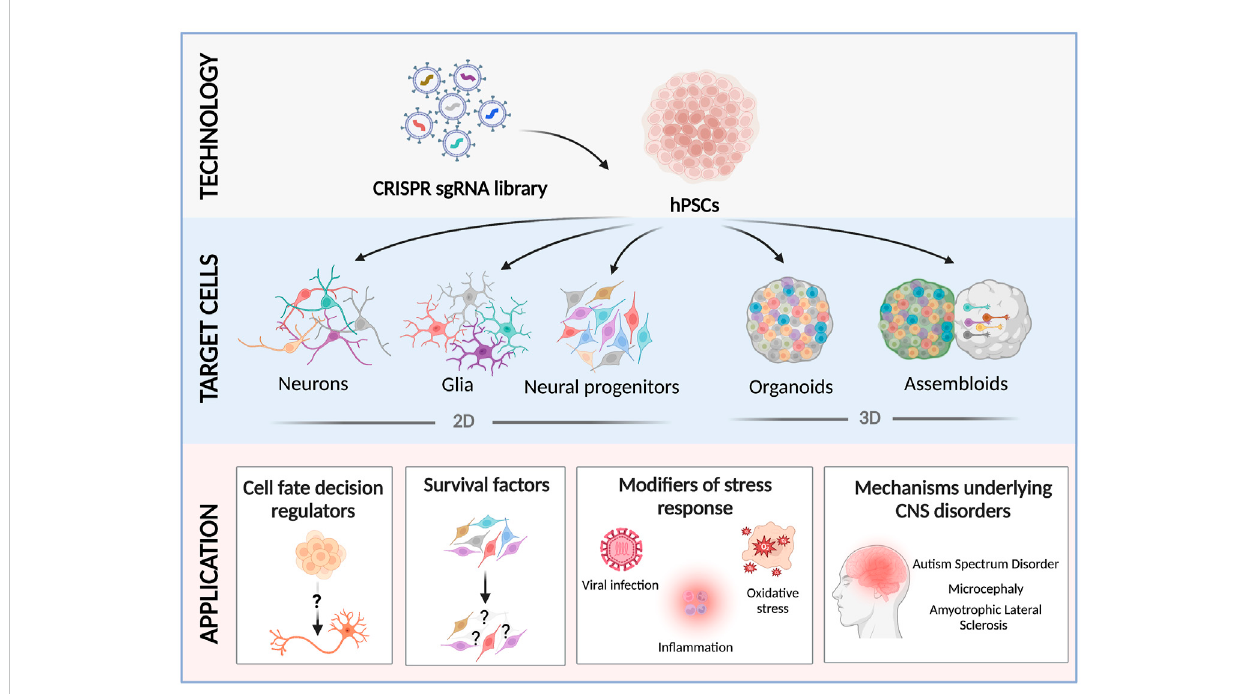
FIGURE 1 Recent applications of CRISPR screens using hPSC-derived neural cultures. hPSCs are transduced with a scalable pooled lentiviral sgRNA CRISPR library, and differentiated into 2D neural cultures (neural progenitor cells (Li et al., 2019), neurons (Tian et al., 2019; Tian et al., 2021), microglia (Dräger et al., 2022), or astrocytes (Leng et al., 2022)), or 3D brain organoids/assembloids (Esk et al., 2020; Fleck et al., 2022; Li et al., 2022; Meng et al., 2022). Screening neural cultures carrying different pooled CRISPR perturbations has revealed novel factors that regulate neurodevelopmental cell fates (Blacketal.,2020;Flecketal.,2022),essential genes(Tianetal.,2019;Tianetal.,2021),modi fi ersofcellsurvivalunderdifferentchallenges (Lietal.,2019; Tian et al., 2021; Leng et al., 2022), and the cellular and molecular mechanisms that underlie neurodevelopmental and degenerative disorders (Esk et